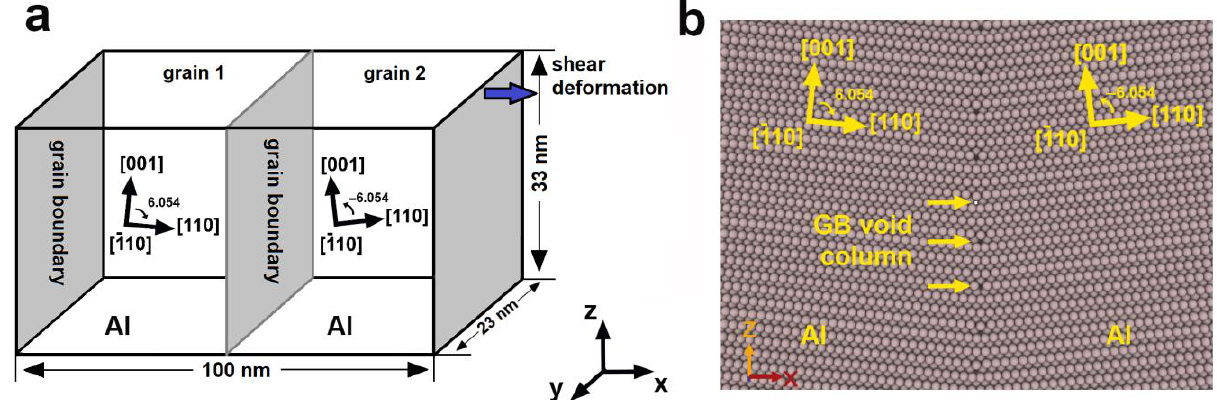
Figure 1. ( a ) Schematic representation of the system containing symmetrical tilt LAGB; ( b ) an atomic structure formed at symmetrical tilt LAGB with a misorientation angle of 12.108 ◦ . Periodically located columns of voids at the GB are visible.